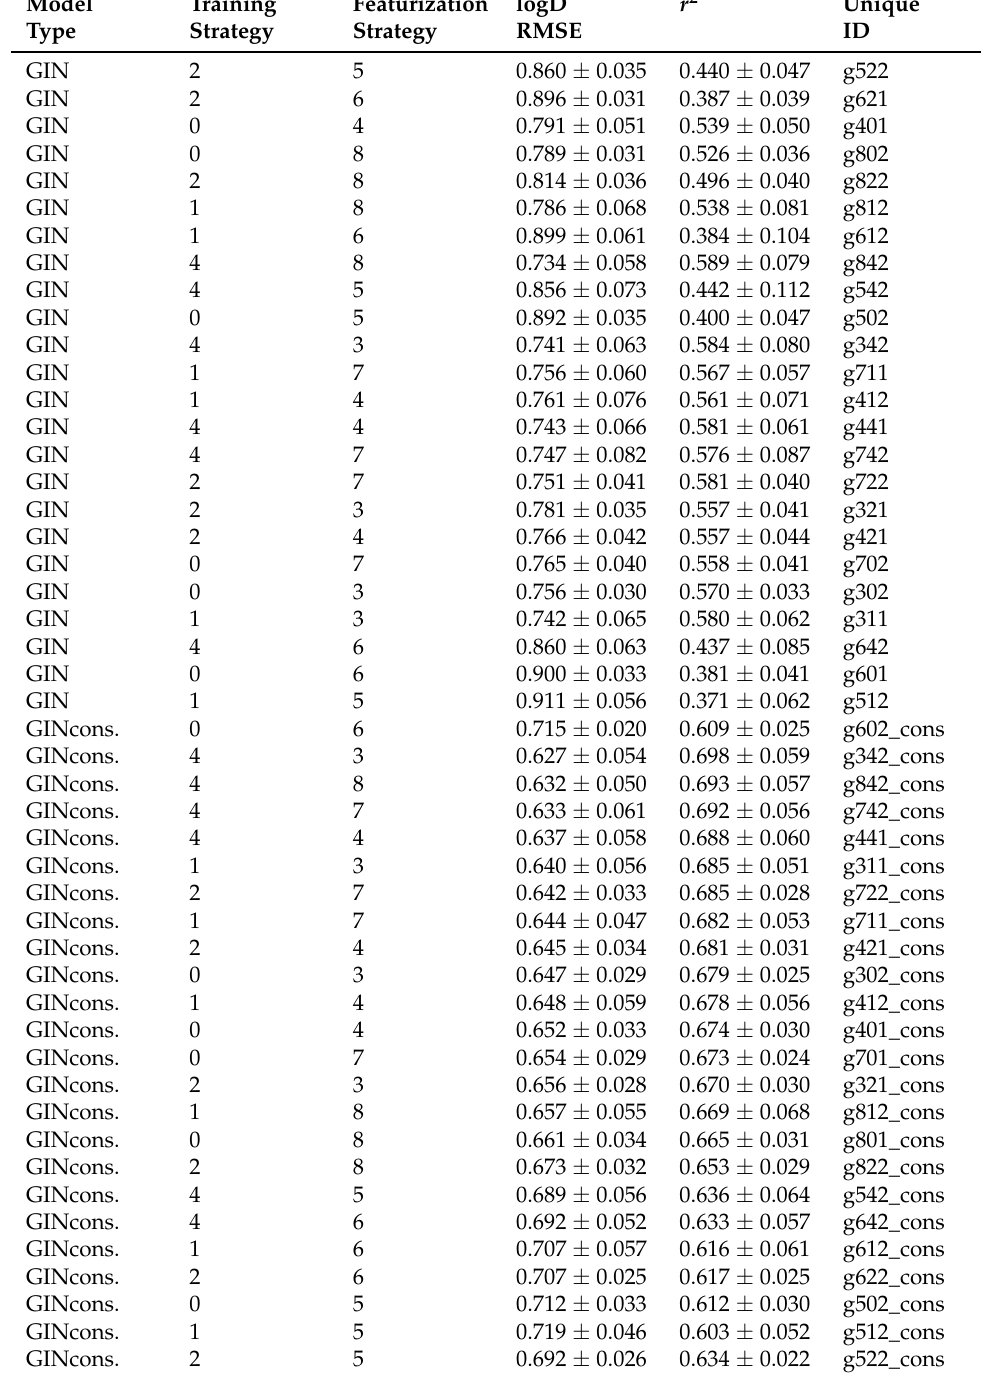
Table A10. Shows the logD RMSE and r 2 results for the GIN model type used during this survey. The last column consist of the unique identify. Training strategy 0 represents a training strategy combining logD, logS, and logP, 1 represents a strategy combining logD and logP, 2 stands for a combination of logD and logS, 3 represents a strategy using logS and logP, 4 represents a strategy using logD, 5 represents a strategy using logS, and 6 represents a strategy using